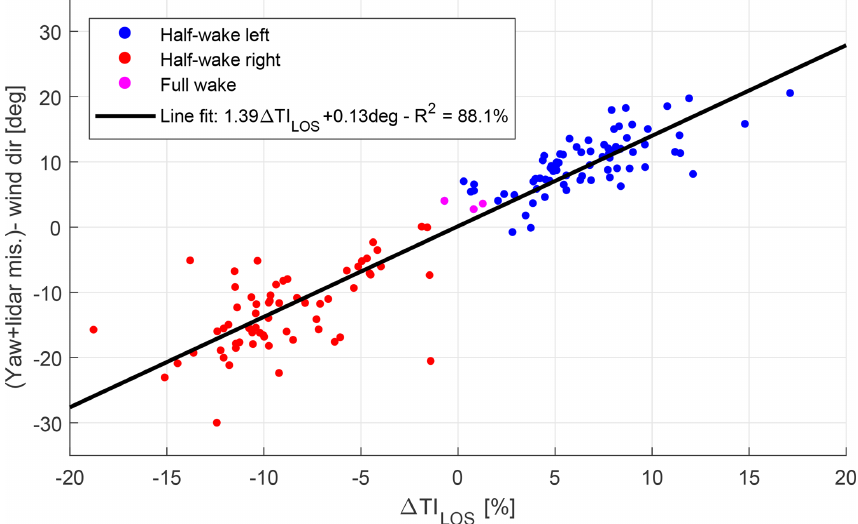
Figure 11. Difference between absolute wind direction estimated from the lidar (i.e. lidar misalignment + turbine yaw position) and sonic anemometer versus the detection parameter (cid:49) TI LOS . Only the observations in which a wake has been identified are shown. The line fit indicates that the data fit well to a linear regression